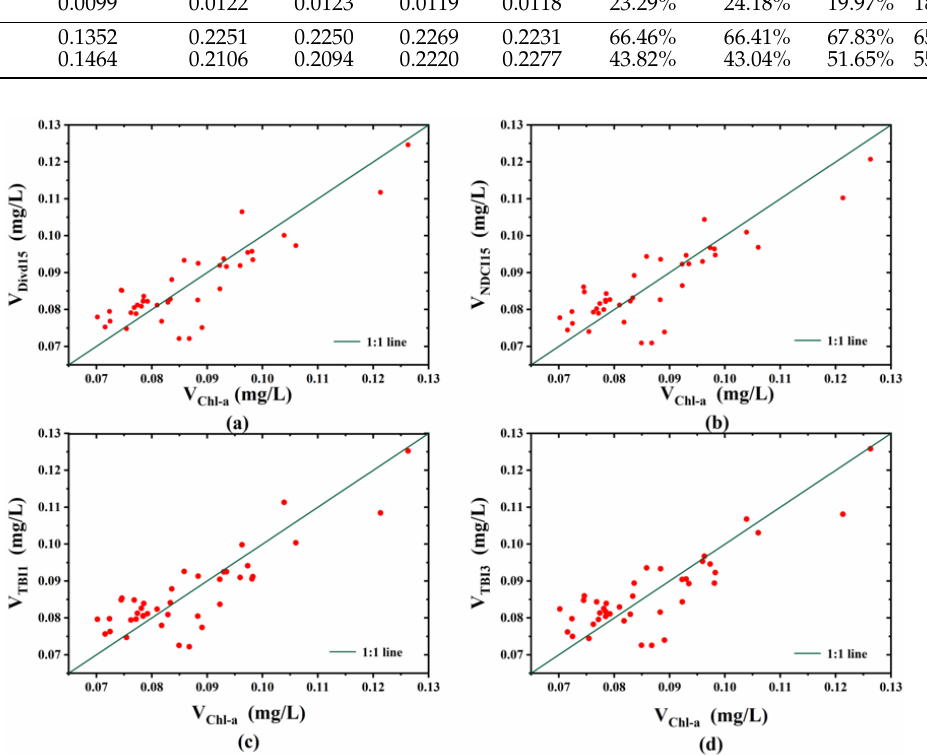
Figure 3. Scatter plot of the retrieved and measured chlorophyll-a concentrations in Dianchi Lake. Subfigures ( a – d ) show the 1:1 line between the simulated chlorophyll-a concentration and the measured chlorophyll-a concentration by Divd15, NDCI15, TBI1 and TBI3, respectively. The NDCI15\TBI3\TBI1\Divd15 model had a good effect on the retrieval of the CCAPL through the error analysis and precision statistics results. Among them, NDCI15 ’ s RMSE, MAE and MAPE were 0.0249, 0.0142 and 26.30%, respectively. Compared with the three other spectral indexes, the NDCI15 model had the advantage of higher accuracy. This was because NDCI15 further improved the reflectance ratio of the two bands via the nonlinear stretching of Band 5 and Band 4, and had good stability and robustness to the difference between the spectral characteristics of the lakes in the plateau area. 4.3. Retrieval of the CCAPL The retrieval model of the CCAPL was selected according to the results of the RF algorithm feature importance, and the accuracy of the model could meet the requirements of the CCAPL retrieval. The CCAPL was retrieved from the Sentinel-2 images of nine plat- eau lakes in Yunnan Province, and the obtained distribution of the CCAPL is shown in Figure 4.